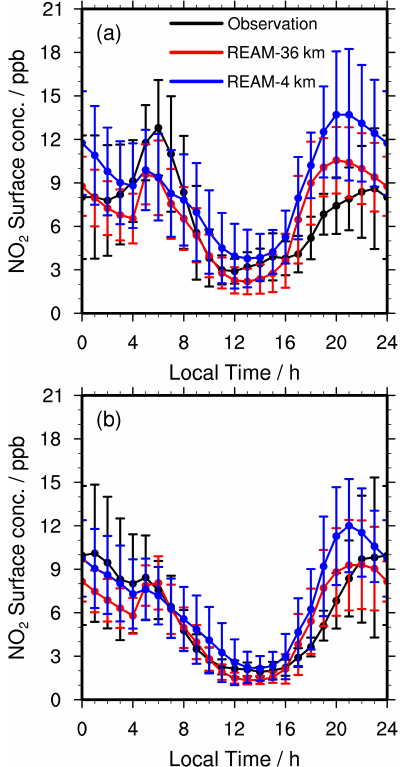
Figure 7. Diurnal cycles of observed and simulated average sur- face NO 2 concentrations over Padonia, Oldtown, Essex, Edgewood, Beltsville, and Aldino (Table S1) on (a) weekdays and (b) week- ends. Black lines denote mean observations from the six sites. Red lines denote coincident 36km REAM simulation results, and blue lines are for coincident 4km REAM simulation results. Error bars denote standard